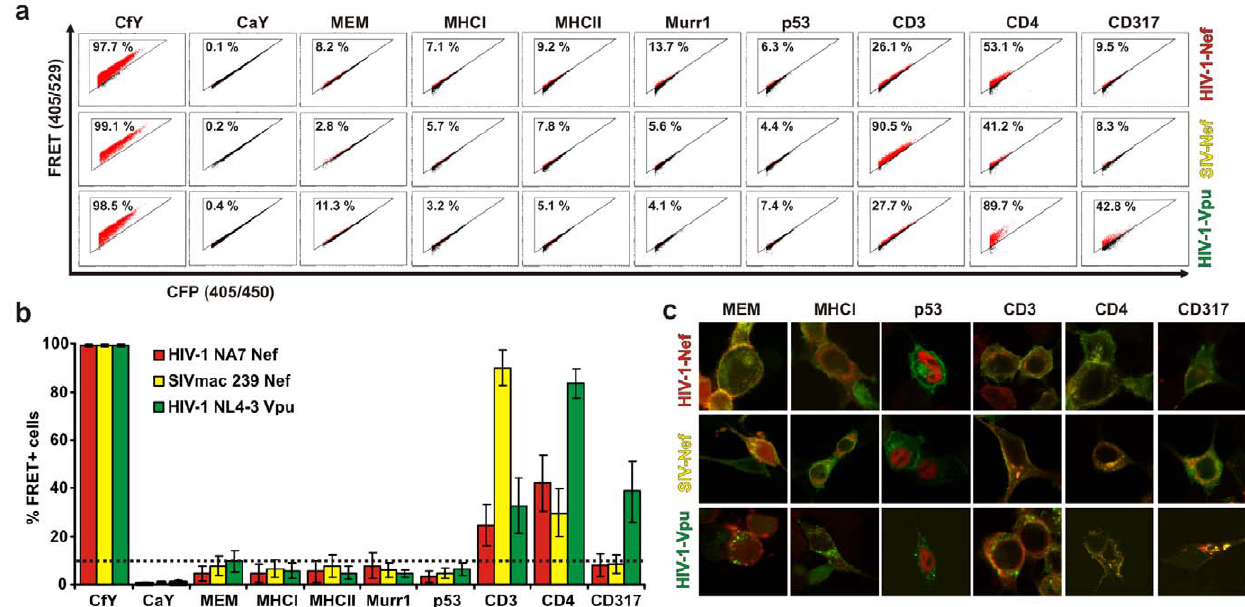
Figure 2. Analyses of protein interactions by FRET. (a) Representative primary FACS-plots showing the amount of FRET + cells in living 293T cells cotransfected with the indicated CFP and YFP fusion proteins. Numbers give total percentages of cells within the FRET gate (compare Fig. 1a panel 3). (b) Mean values and standard deviations (SD) for the total amount of FRET + cells from a minimum of eight independent experiments that were analysed as depicted in (a). The dotted line gives the maximum background FRET-signal that was obtained when cells were cotransfected with the MEM-CFP control and the YFP fusion proteins. Abbreviations: CfY, CFP fused YFP; CaY, CFPonly and YFP-fusion. (c) Merged images from confocal pictures of 293T cells that were cotransfected with the Nef/Vpu-YFP fusion proteins (shown in green) and the indicated CFP-fusions (shown in red). Regions in which both fusions colocalize appear yellow.